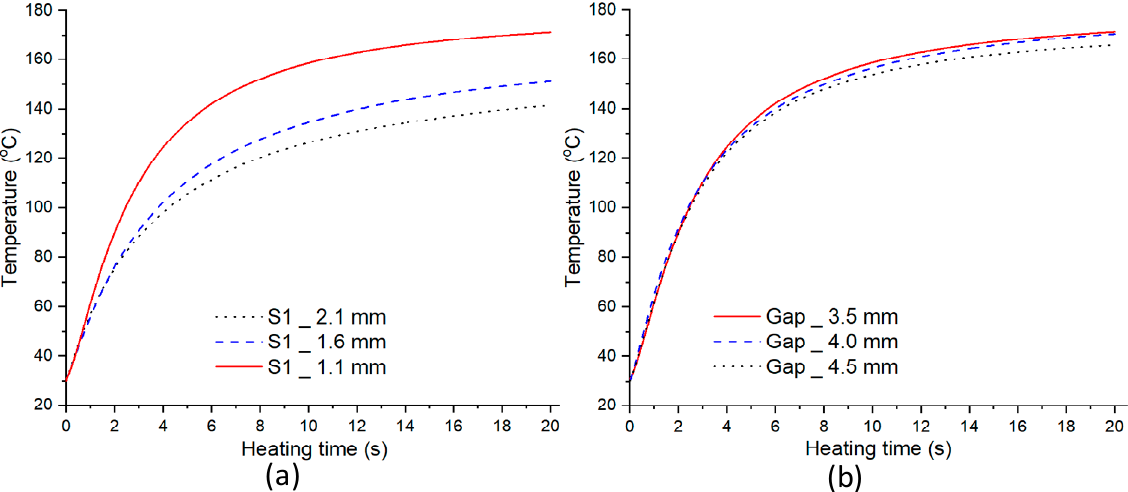
Figure 9. Temperature comparison at the center of the heating area (Point S1) in the simulation at 300 °C with different stamp thicknesses ( a ) and gas gap lengths ( b ).